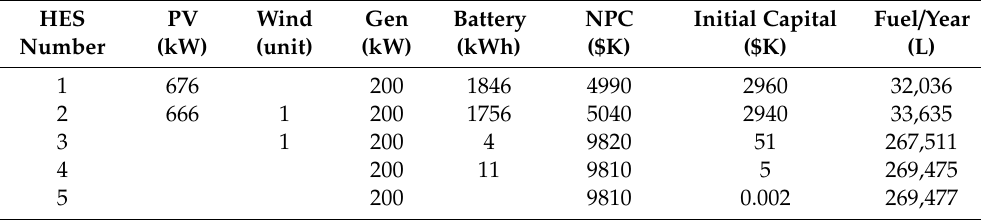
Table 4. Resulting HOMER optimal combinations of components. PV: photovoltaic and NPC: net present cost.